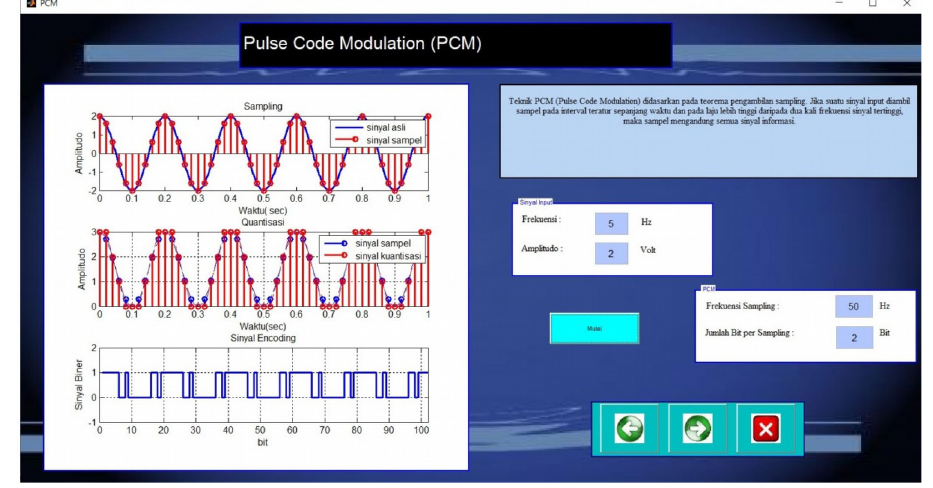
Figure 1. PCM signal